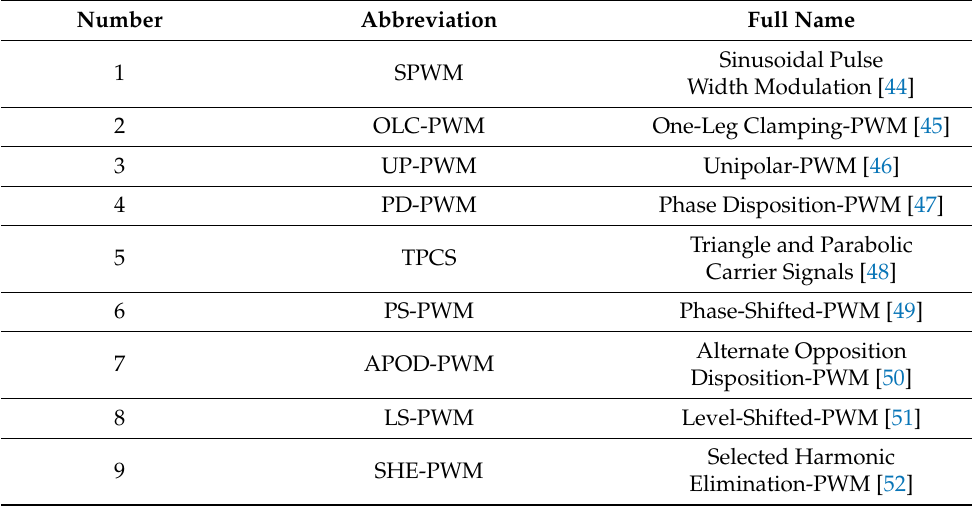
Table 3. Abbreviations of control strategy